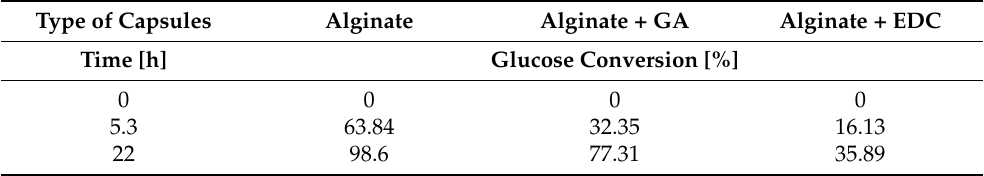
Table 3. The enzymatic activity (a glucose conversion degree) observed in the solution after the capsules removing, (glucose 2.38 g/L, 0.1 M HEPES buffer pH 6,6, 25 ◦ C, CaCO 3 4 g/L, without